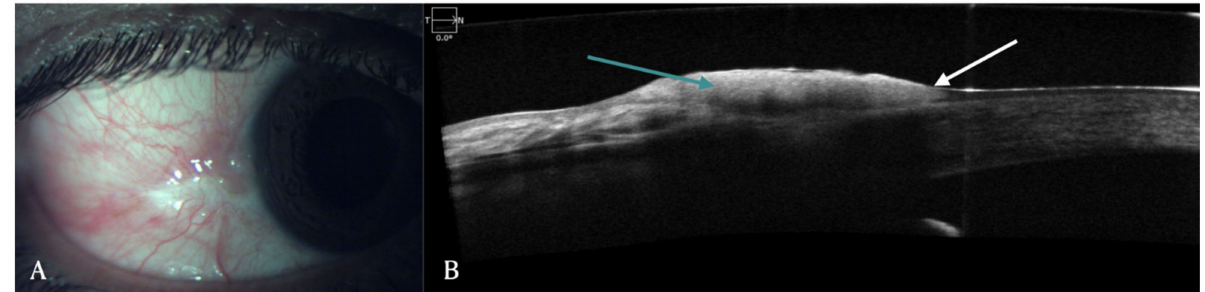
Figure 1. ( A ) Clinical picture of OSSN in a 51-year-old male patient. ( B ) Corresponding AS-OCT image showing thickened and hyper-reflective epithelial layer (green arrow) with abrupt transition from normal to abnormal epithelium (white